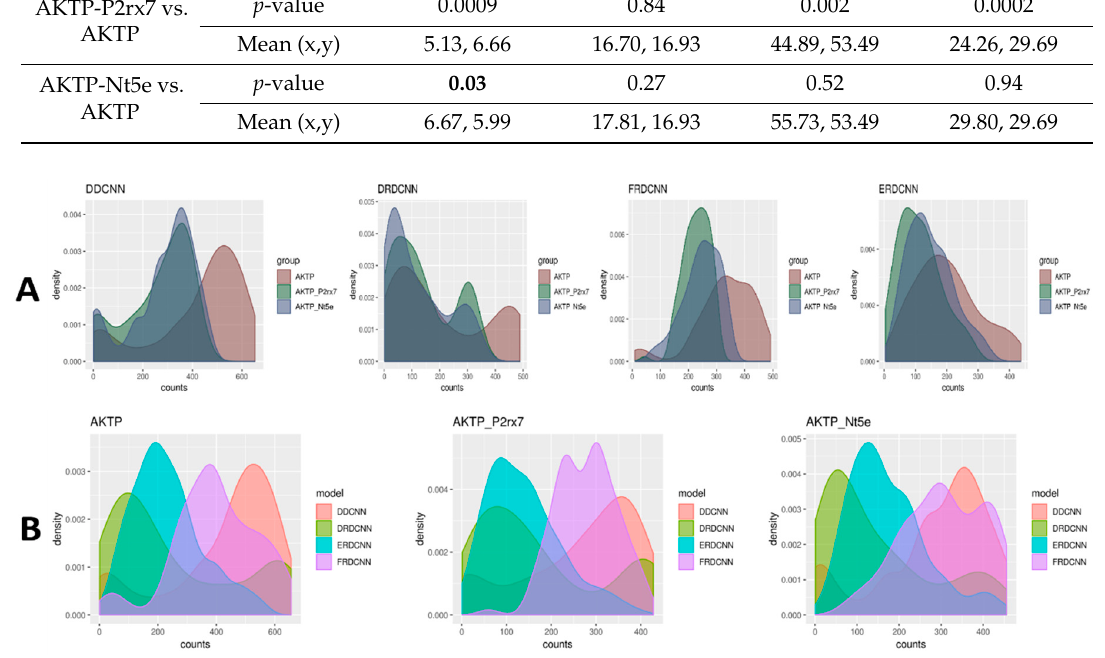
Figure 4. Density plots of the predicted cell counts for the three experimental groups from the four models. ( A ) Each plot compared the predictions of the three experimental groups using the same model. ( B ) Each plot compared the predictions of the four models for the same experimental group.